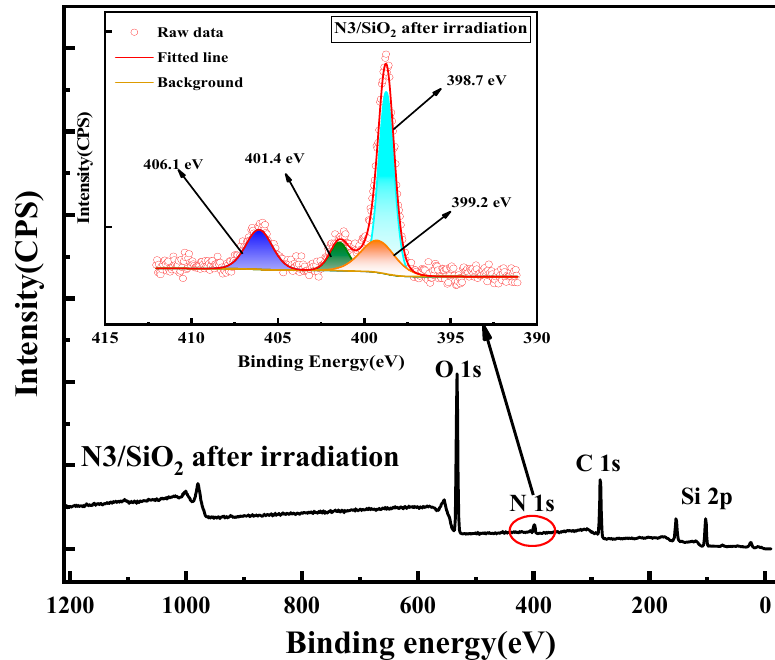
The XPS spectrum of the N3/SiO 2 with an absorbed dose of 100 kGy was further analyzed. In Figure 6, the N 1s spectrum of irradiated N3/SiO 2 could be decomposed into four peaks, consistent with the fresh adsorbent. The areas of the two peaks near 399.2 eV and 401.4 changed greatly, which may be due to the gamma irradiation on the protonation process of the adsorbent. process of the adsorbent.